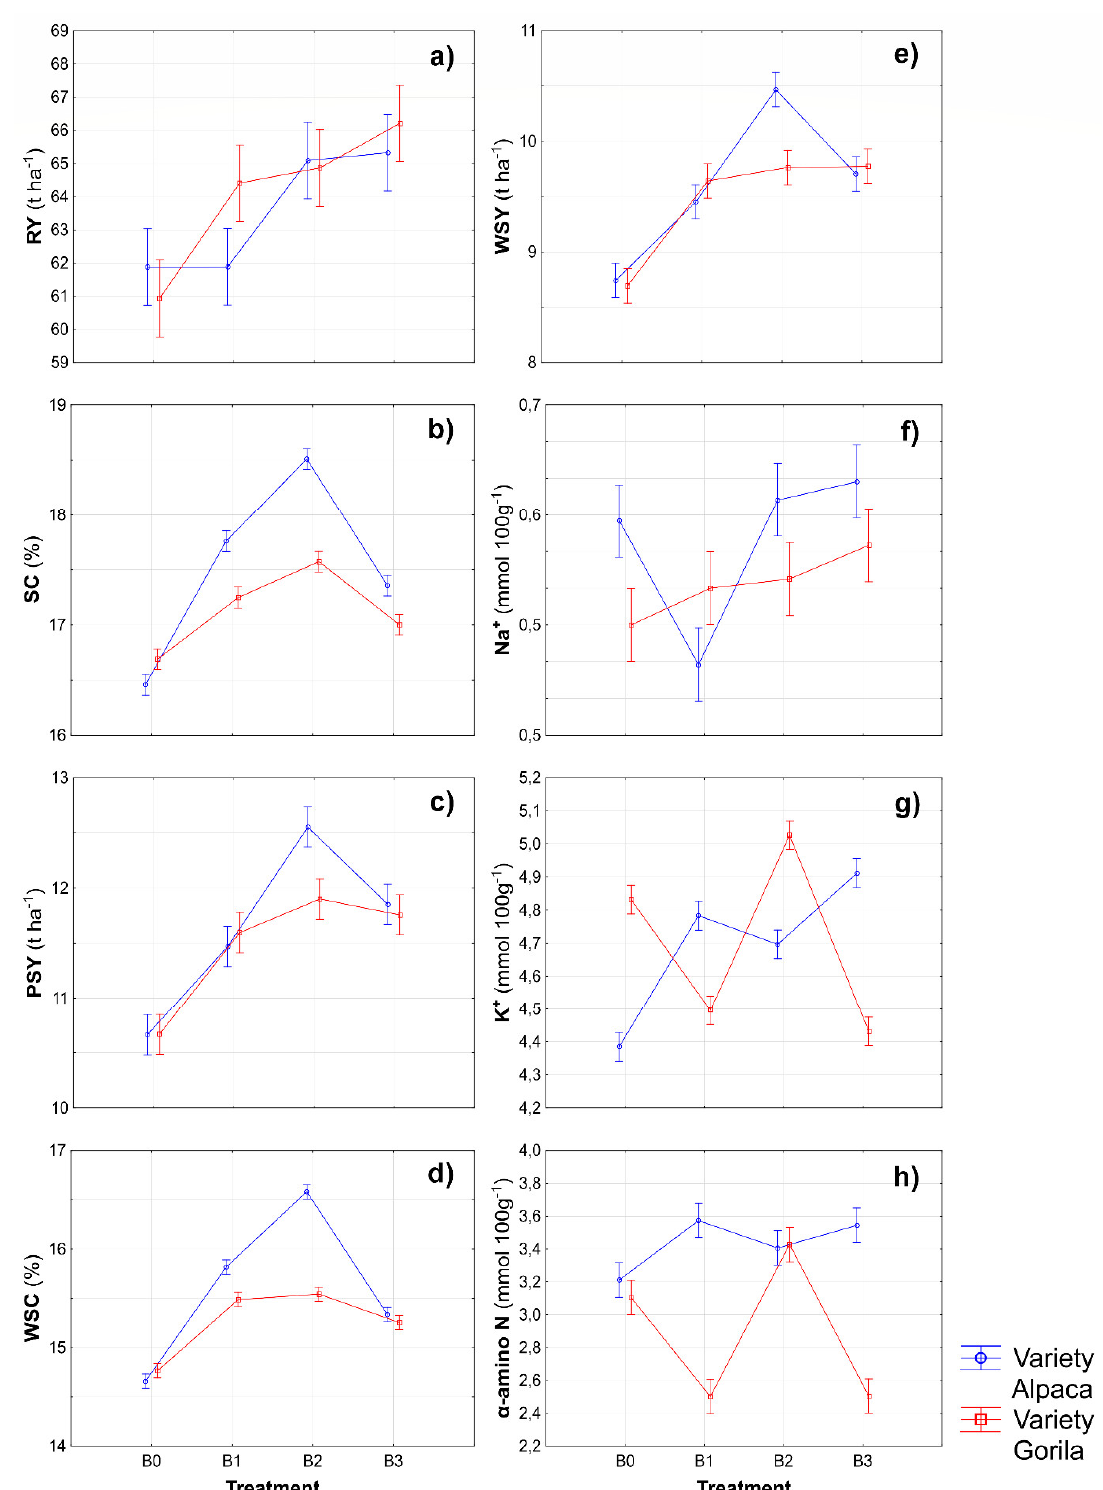
Figure 5. Interactions between biostimulants and varieties for root yield ( a ), sugar content ( b ), polarized sugar yield ( c ), white sugar content ( d ), white sugar yield ( e ), sodium content ( f ), potassium content ( g ) and α-aminonitrogen content ( h ). B0—control; B1—humic acids, essential amino acids; B2—essential amino acids biopolymers, soil bacteria; B3—humic acids, essential amino acids biopolymers, soil bacteria. The figure was obtained at a level of significance α = 0.05.